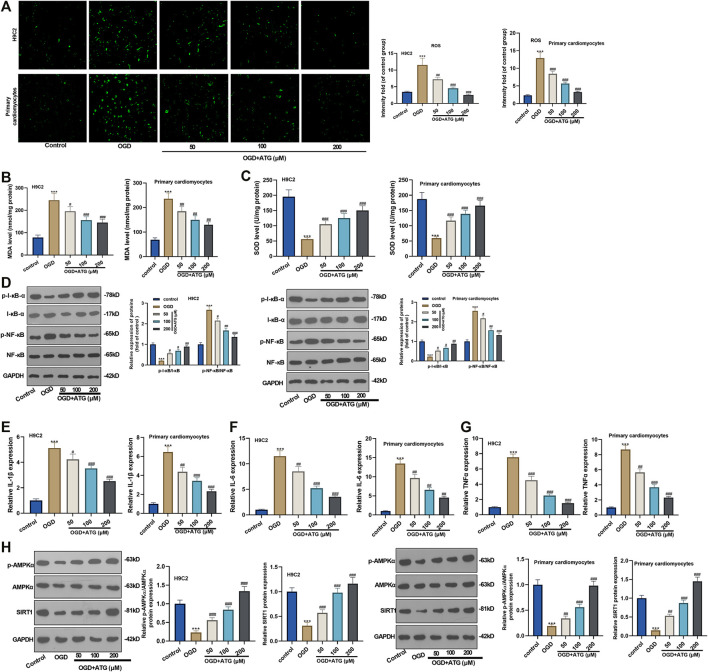
Arctigenin inhibited OGD-mediated oxidative stress and inflammation in vitro. On the basis of OGD treatment on H9C2 cardiomyocytes and Primary cardiomyocytes, different concentrations (50, 100, 200 µM) of Arctigenin were given for intervention. (A) Using DCFH-DA fluorescent dye to study Arctigenin’s effect on OGD-induced ROS levels in H9C2 cells and Primary cardiomyocytes. (B, C) RT-PCR experiment was taken to examine the content of MDA and SOD activity in OGD treated-cardiomyocytes. (D–G) Western blot and RT-PCR experiments were utilized to assess the protein expression of NF-κB/I-κB and the levels of inflammatory factors IL-6, IL-1β and TNF-α. (H) Western blot assay to detect the protein expression of the AMPK/SIRT1 pathway. ***p < 0.001 (vs.control group), #p < 0.05, ##p < 0.01, ###p < 0.001 (vs.OGD group), N = 5.